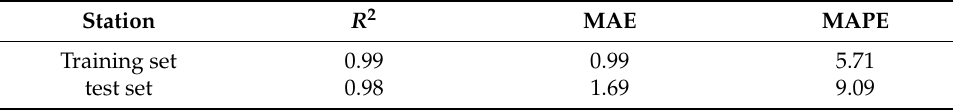
Table 5. Summary of error statistics of applied